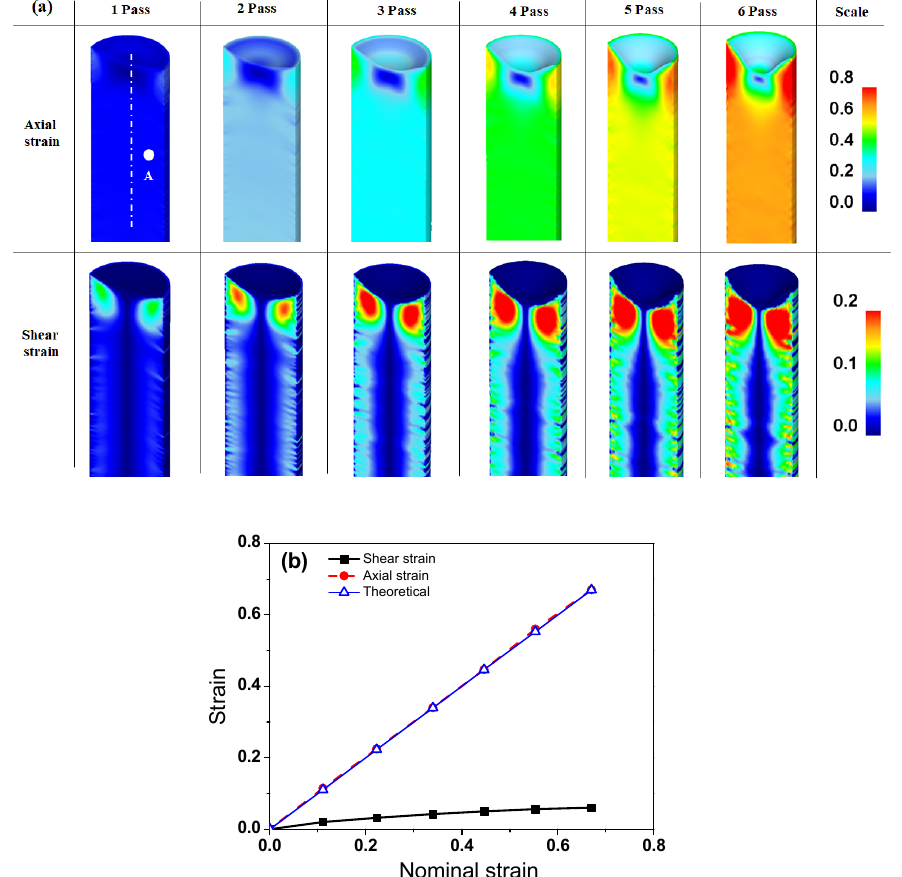
Figure 13. Comparison of the ( a ) axial and shear strain contours and ( b ) variation in strain at point A marked in ( a ) of the drawn wire with the drawing pass. Theoretical strain was obtained using Equation (2).